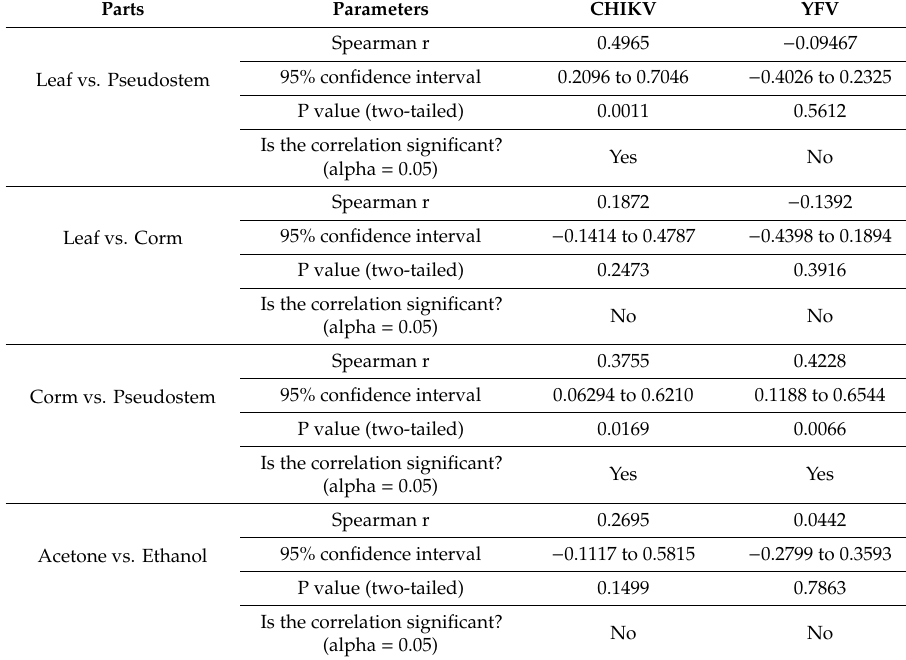
Table 4. Calculation of nonparametric correlation (Spearman r) of EC 50s between di ff erent plant